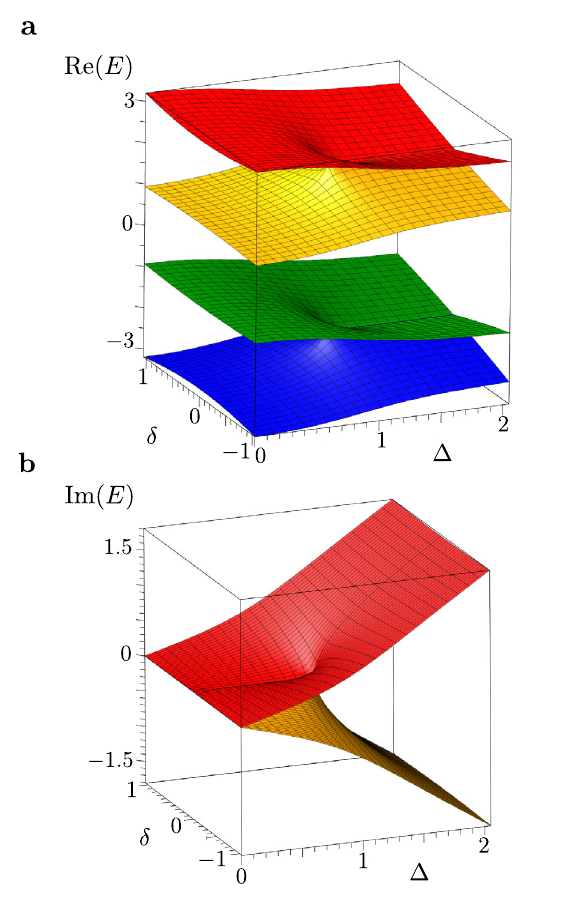
Fig. 2 | Spectrum of a four-mode PT -symmetric system. Real a and imaginary b partsofthespectrumofthenon-HermitianHamiltonian,NHH, H ( δ )inEq.(6).For real-valued energies, the spectrum of the NHH is formed by two pairs of Riemann surfaces, whereas for the imaginary-valued spectrum, those two pairs coincide. Each pair of Riemann sheets, for a given value of g , has a branch cut at an excep- tional point determined by the conditions Δ =1 and δ =0. The system parameters are: k =1 and g